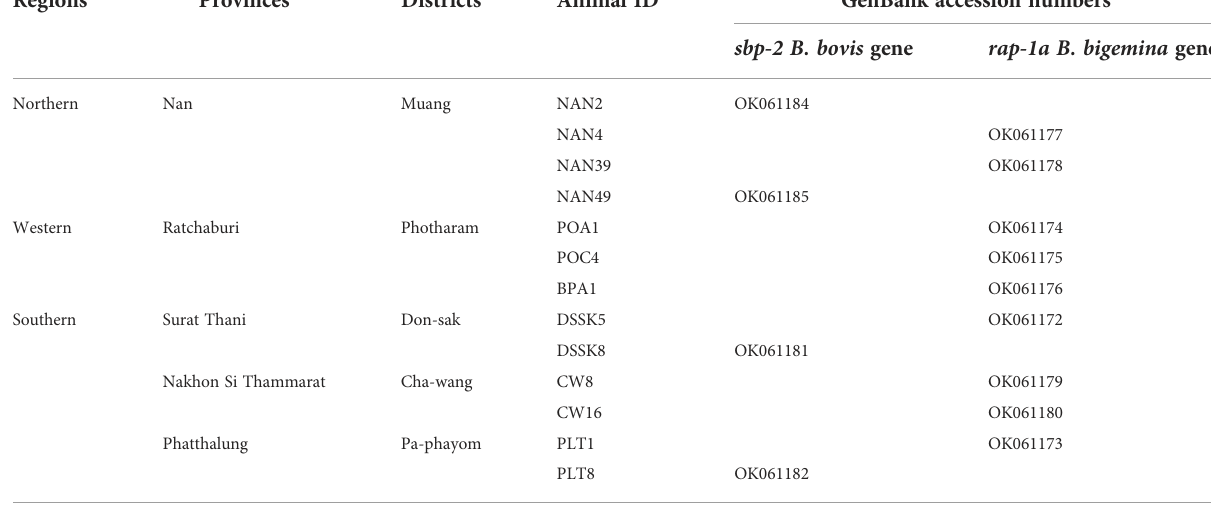
TABLE 1 The Babesia spp. nucleotide sequences ampli fi ed in Thailand strain were deposited in the GenBank database.